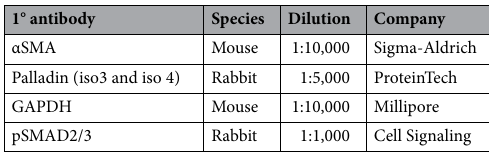
Table 2. List of SDS-PAGE primary antibodies.